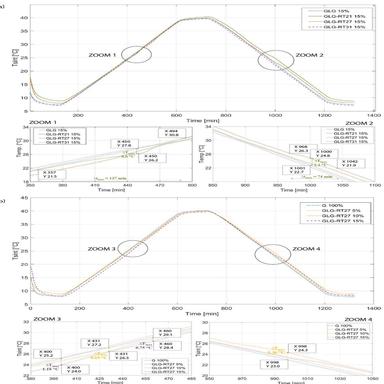
Ts,int,int of a) lignin compounds at 15 % and b) G and GLG-RT27 at the various percentage.